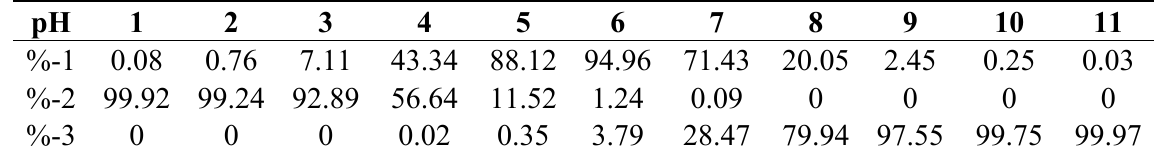
Table 1. Percentage of ionization of IRB depending on pH.